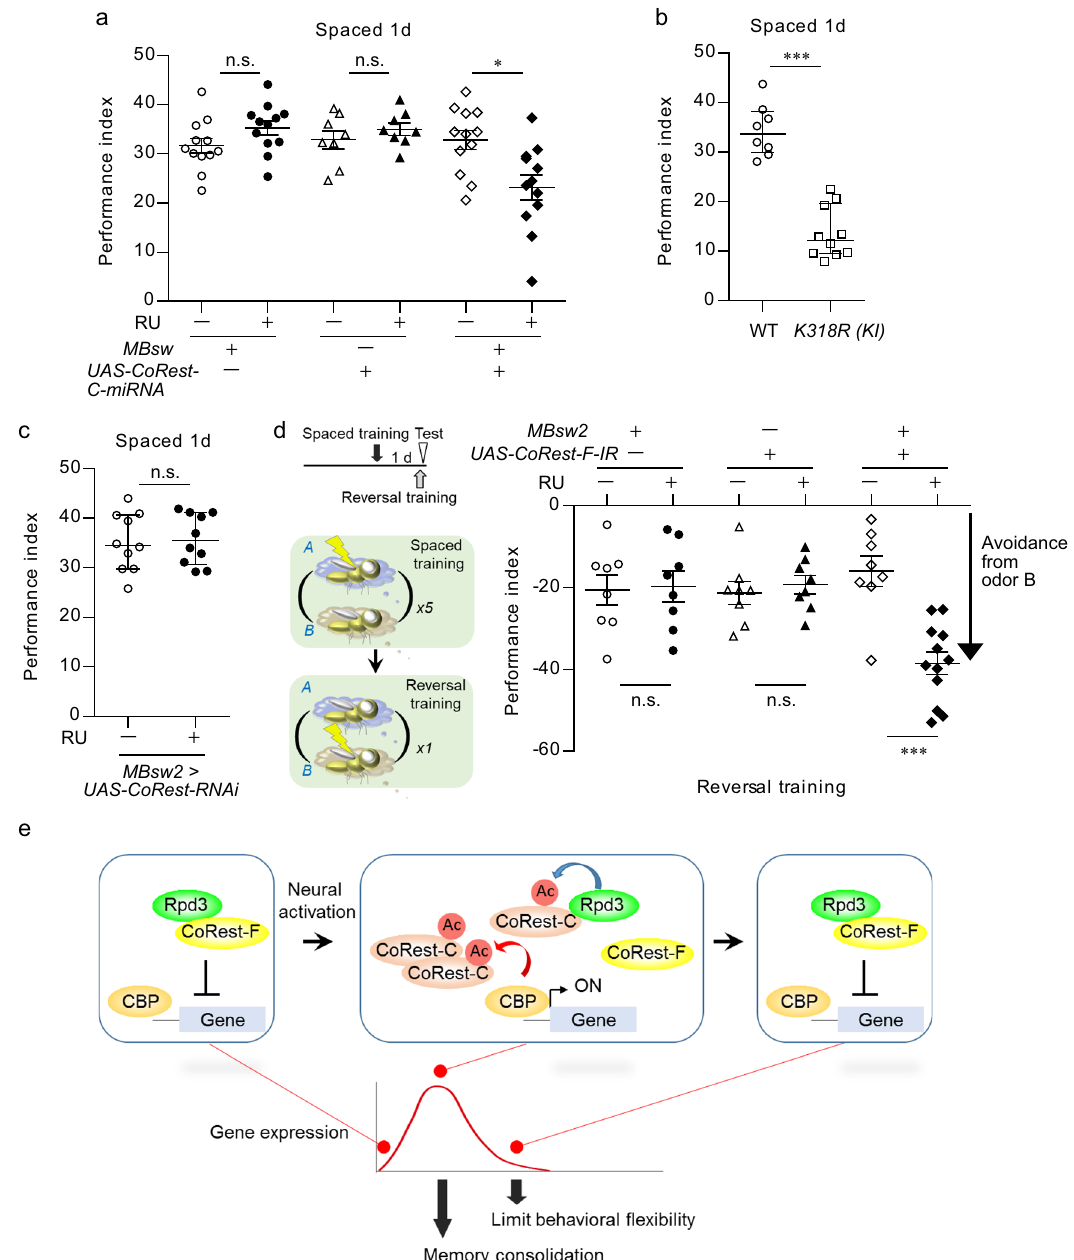
Fig. 7 CoRest-C is required for memory consolidation, whereas CoRest-F is required to limit behavioral fl exibility. a , b Dysfunction in CoRest-C impaired memory consolidation. The fl ies with indicated transgenes were fed RU in a , or normal food in b , and 1-day memory after spaced training was analyzed. a A Kruskal – Wallis test ( P = 0.0027; n = 12) followed by Dunn ’ s multiple comparison test (two sided) was performed. b Two-sided Mann – Whitney U -test, P < 0.0001; n = 8 – 10. K318R (KI) , CoRest-C-K318R knock-in mutant. c Knockdown of CoRest-F did not affect memory consolidation. The fl ies with indicated